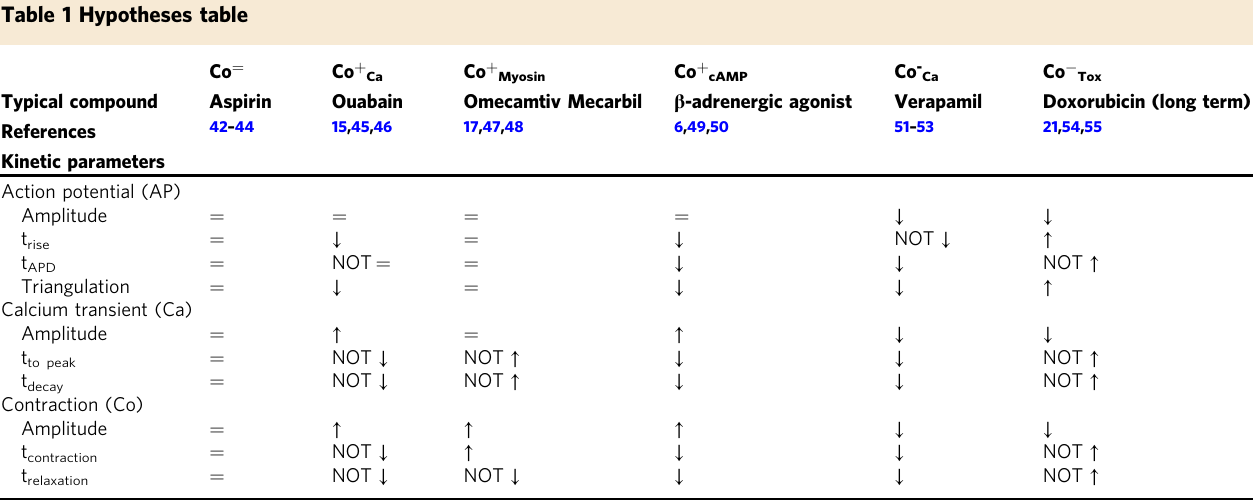
Expectedeffectsonkineticmeasuresofactionpotential(AP),cytosoliccalciumtransient(Ca)andcontraction(Co)percontractilemechanismofaction(MOA). ↓ :decrease; ↑ :increase; = :nodifference. NOT [effect] means all other effects than [effect] might be expected, depending on the speci fi c drug within the MOA